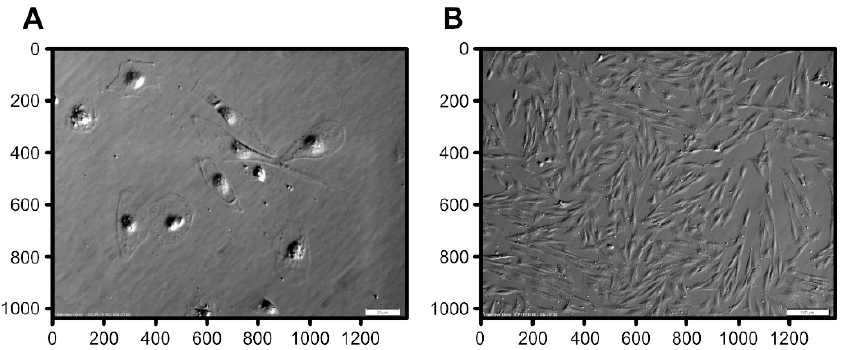
Figure 1. Raw DIC images considered in this study acquired at 40× ( A ) and 10× ( B )